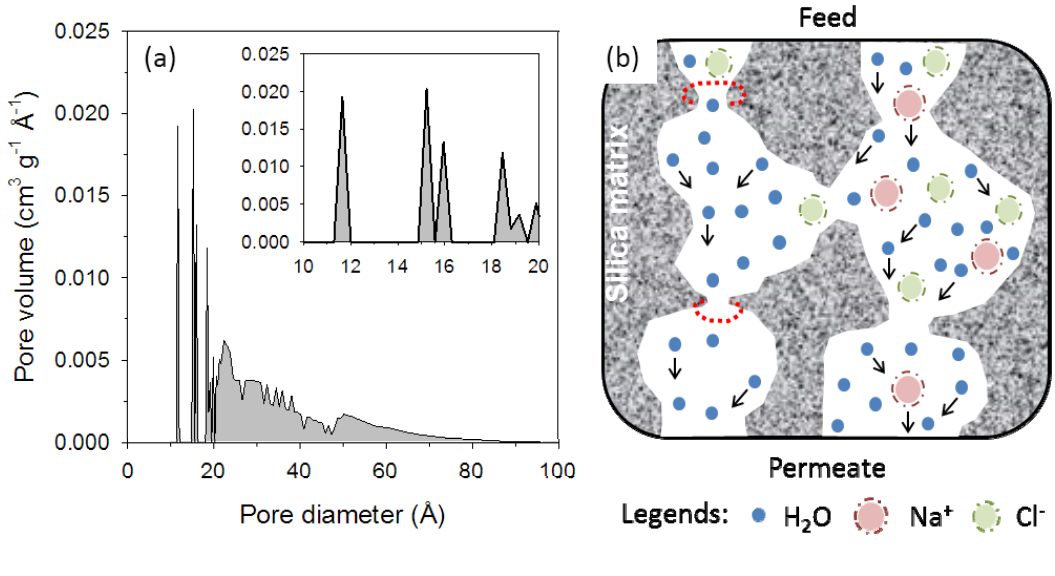
Figure 8. ( a ) Pore size distribution the xerogel sample using the density function theory method with inset displaying between 10 to 20 Å and ( b ) Schematic illustrating percolative porous pathway and diffusions of water and hydrated salt ions through the pores of the silica matrix with the red halos representing the location of the microporous